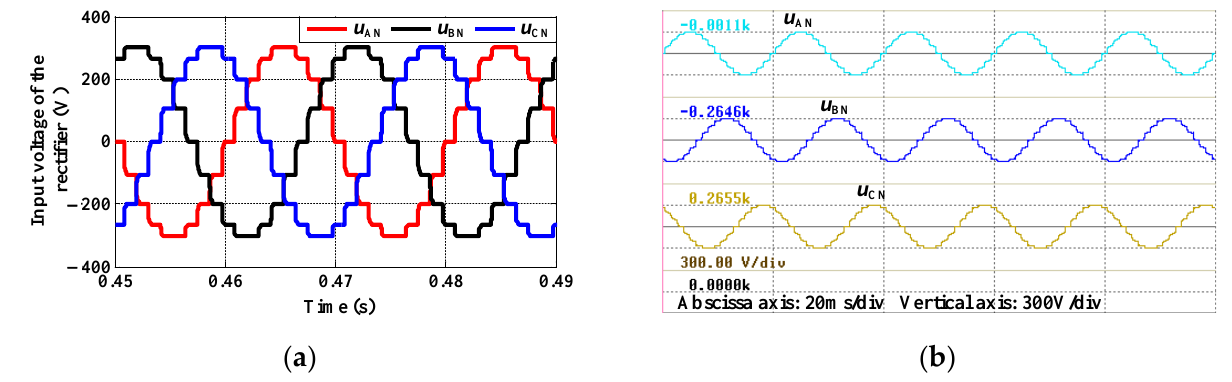
Figure 11. Input voltage of the 18-pulse rectifier without the reduction method. ( a ) Simulation result. ( b ) Experimental result.